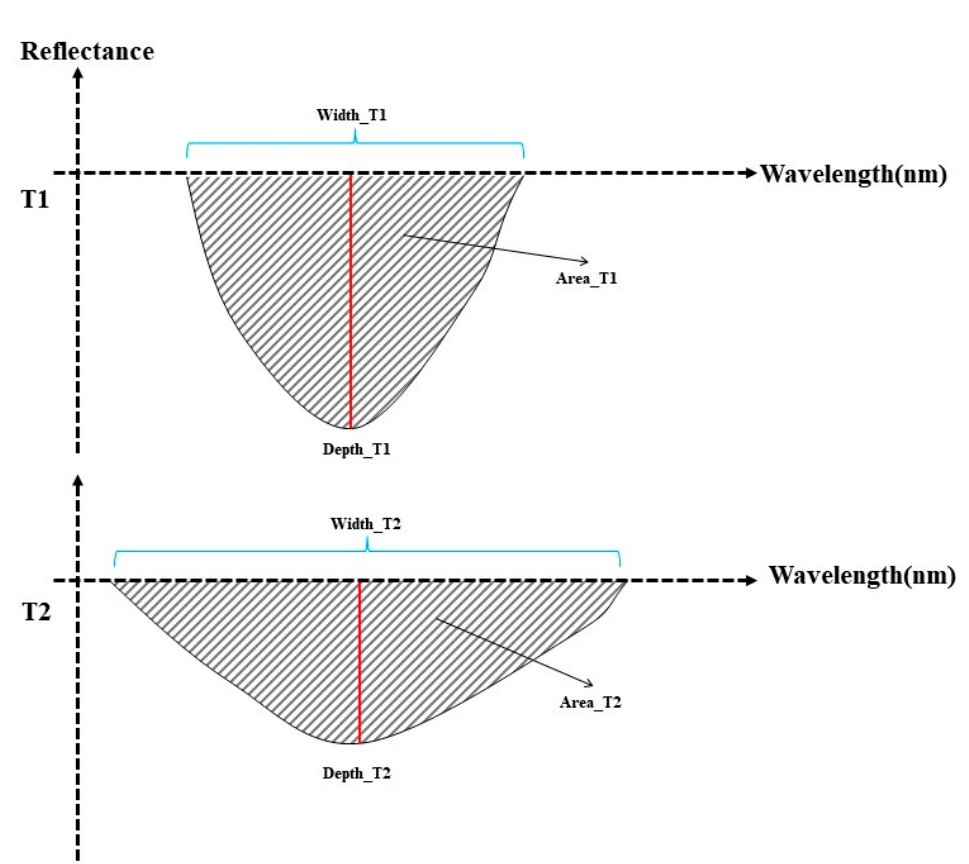
Figure 7. Schematic diagram of the morphological changes of the second and third absorption bands on T1 and T2.